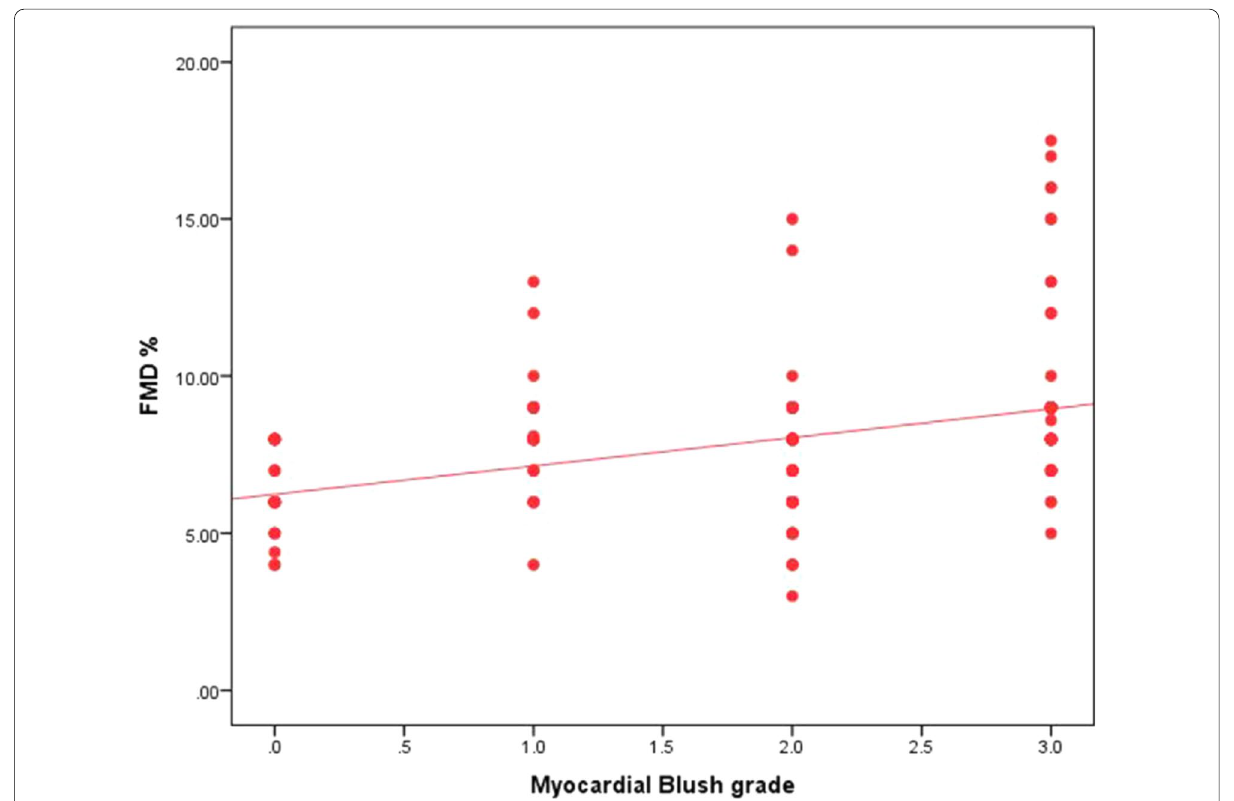
Fig. 3 Correlation between FMD and MBG